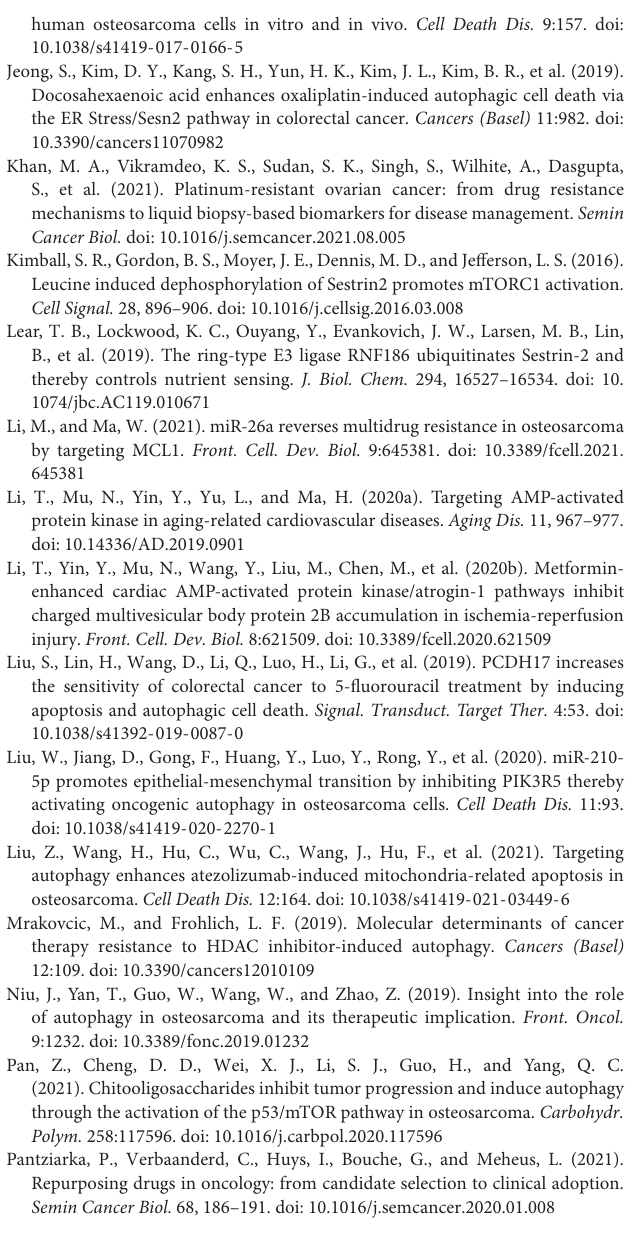
Supplementary Figure 3 | MG-63 and HOS cells were transfected with pHBLV control or pHBLV sestrin2, and the transfection effect was detected by quantitative real-time PCR ( n = 3). Supplementary Figure 4 | SESN2-knockdown HOS cells were treated with Cis (20 µ mol/L) for 24 h with or without rapamycin (100 nmol/L) for 6 h. Proliferation was analysed by CCK-8 assay ( n = 3). Supplementary Figure 5 | The red arrows are autophagosomes in Figures 3D , 4E , 5A